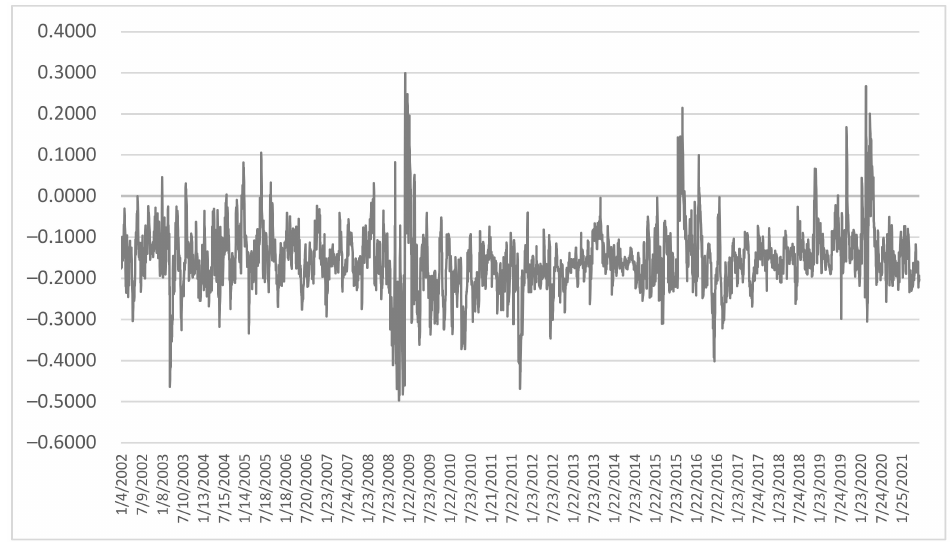
Figure 2. Estimation of the dynamic conditional correlation from model DCC(1,1) GARCH with the multivariate Student’s-t errors, between WTIF and